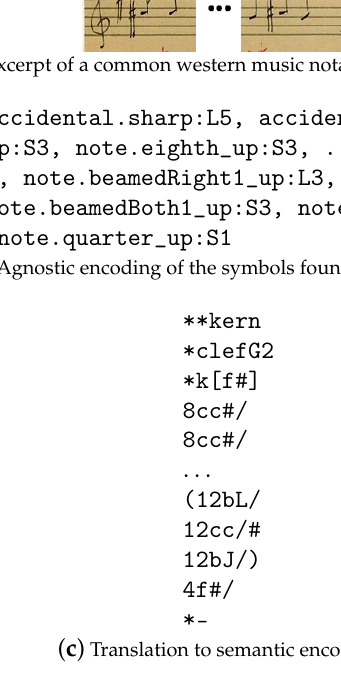
Figure 1. An example of the translation of the agnostic encoding corresponding to a common western music manuscript excerpt shown in ( a ) to a semantic encoding, see their representations in ( b ) and ( c ). Note how the meaning of the two accidentals after the clef is disambiguated into a G major key and an accidental of the first eighth